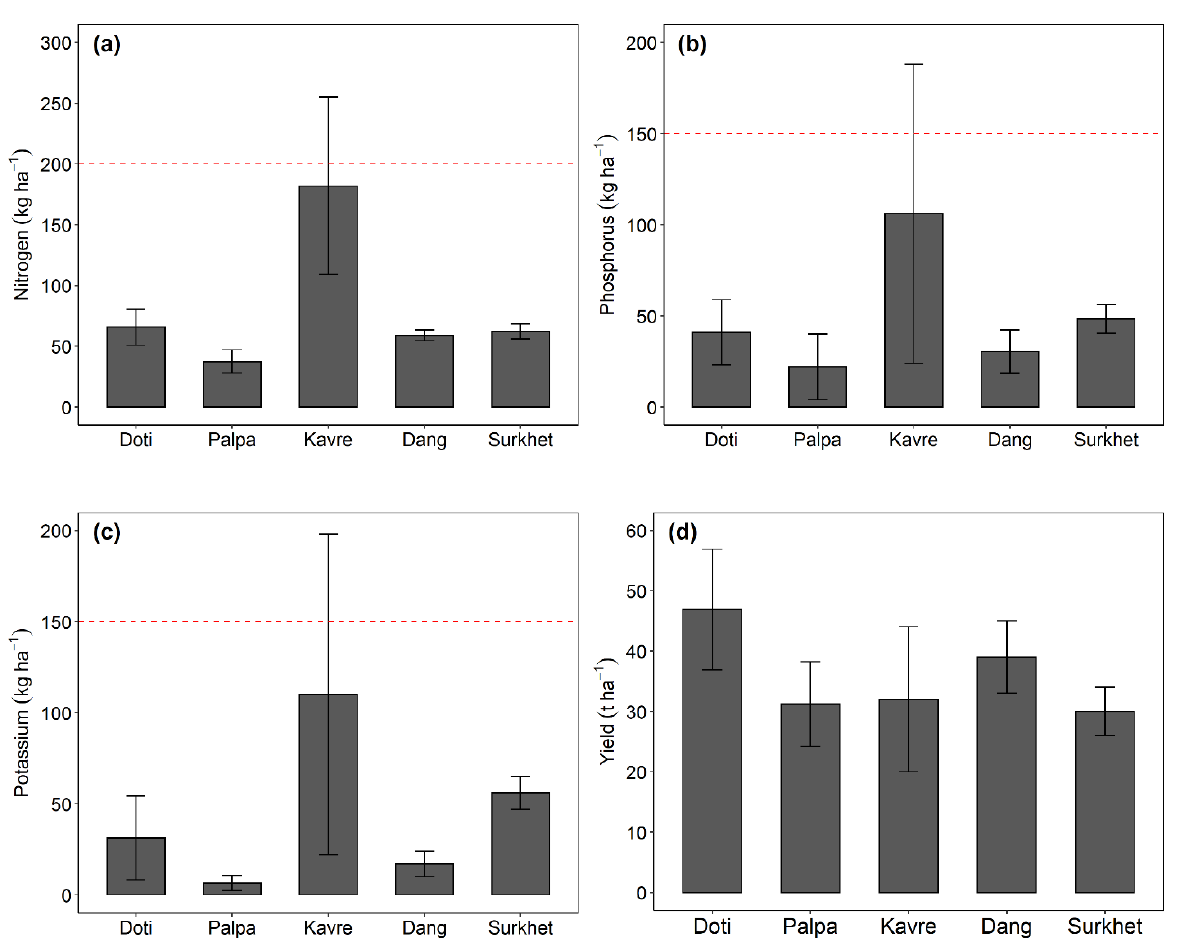
Figure 1. N ( a ), P ( b ) and K ( c ) fertilizers used by farmers across the study districts i.e., Doti ( n = 18), Palpa ( n = 17), Kavre ( n = 10), Dang ( n = 36) and Surkhet ( n = 12); mean ± SE. The red dashed lines in a, b and c indicate the recommended N, P and K fertilizer rates in Nepal, respectively. Tomato yields ( d ) were from farmers’ fields with their own fertilization practices.